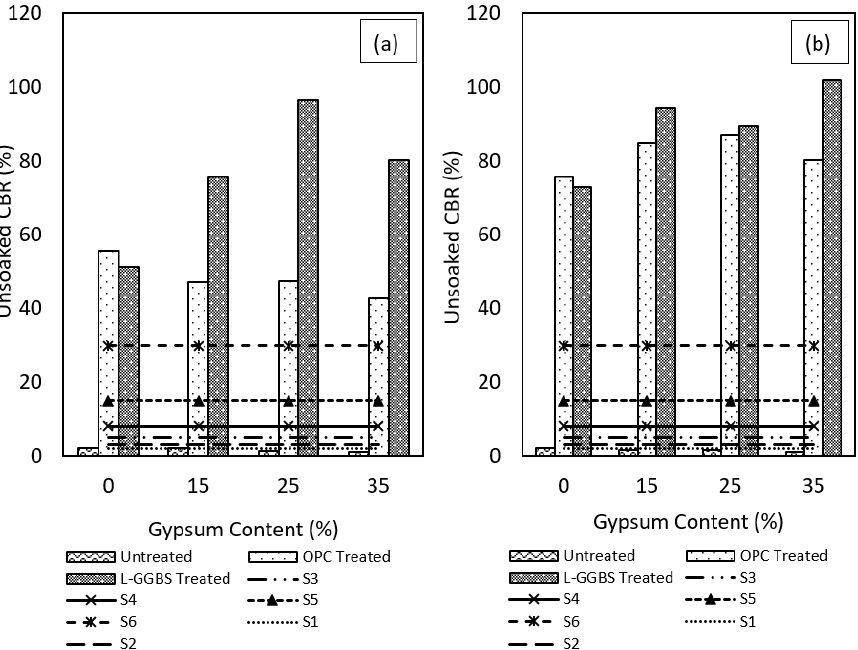
Figure 10. Unsoaked CBR results for OPC and LGGBS treated gypseous soils. ( a ) 7-days cured. ( b ) 28-days cured.